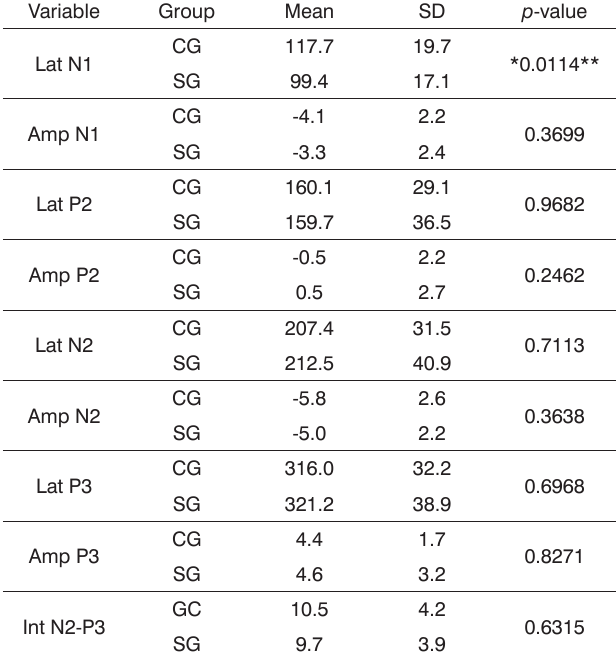
Table 1. Descriptive statistics of the mean, standard deviation (SD) and p -value of the N1, P2, N2, P3 amplitude and latency variables and RE P300f N2-P3 inter-amplitude